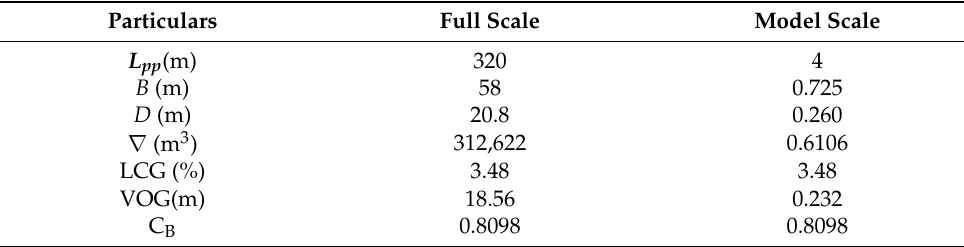
Figure 7. Ship models. ( a ) KVLCC2 model; ( b ) “Yukun”